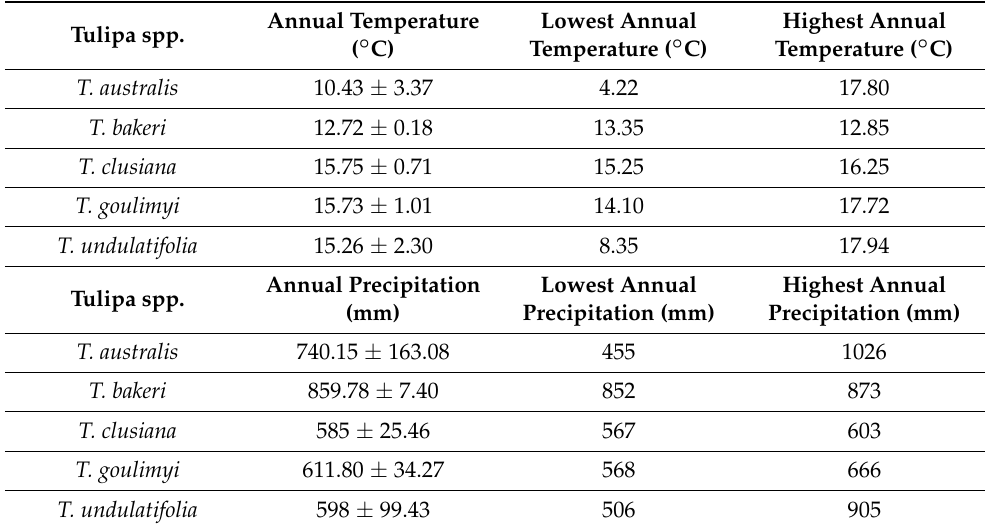
Table 2. Extreme precipitation and temperature limits based on the respective ecological profiles of the five Greek Tulipa spp. studied herein (Figures